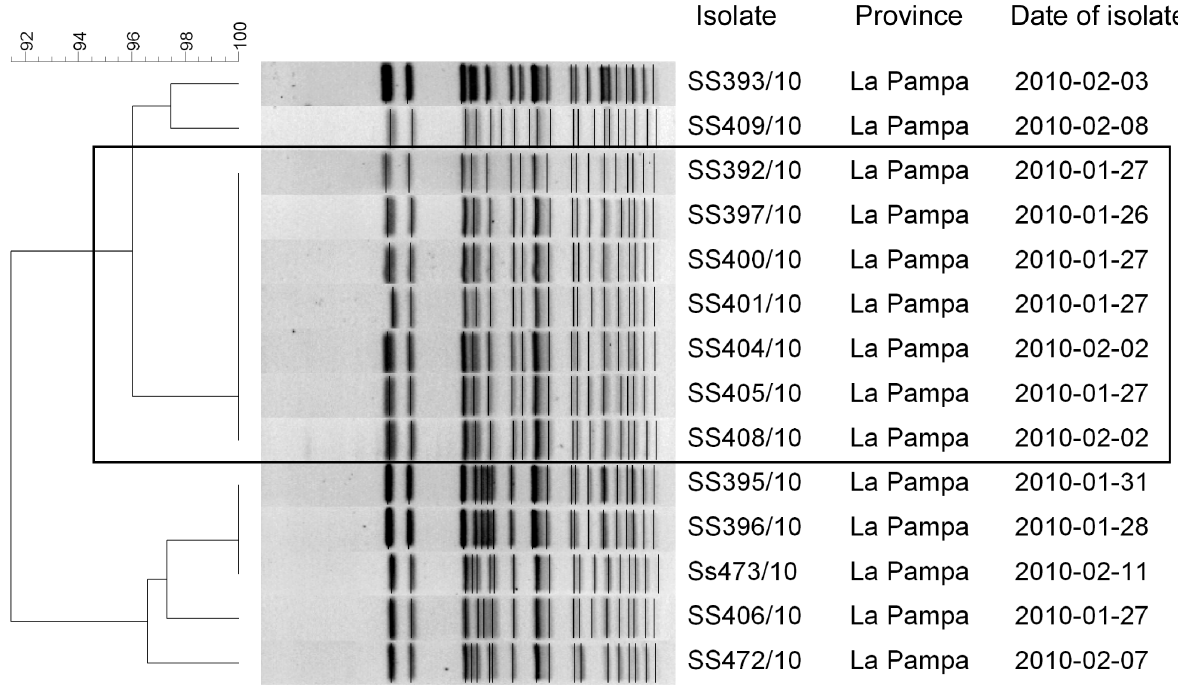
PLOS Neglected Tropical Diseases |